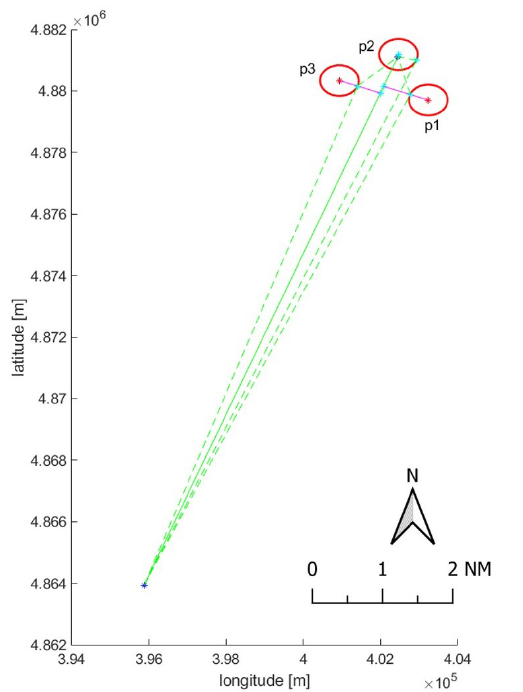
Figure 9. Graphical representation of a suspicious blackout (green line) in proximity of an offshore gas field (platforms p1, p2 and p3). Blu points consist of the latest ping before the switching off and first available ping after the power on, while cyan markers are the contact points between the 500 m safety zones (red circles) and the minimal potential routes (dashed green lines) that the vessel could follow to enter the forbidden